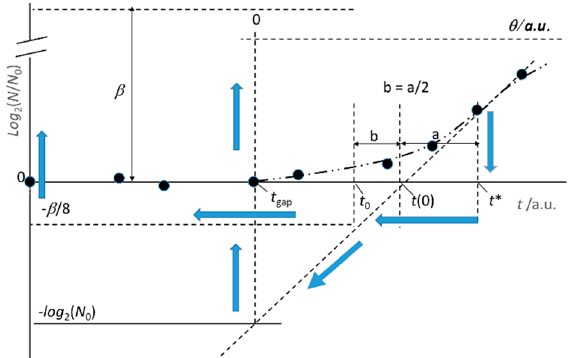
Figure 2. Preliminary steps for a naked eye prediction of the growth parameters. The arrows indicate the estimation steps, according to the guidelines reported in the text. The variable time is “ t ” or “ θ ” for the experimenter and the microbial culture, respectively. Dotted lines correspond to a naked eye estimation. The values of t gap , t 0 , t (0), t *, and β are tentative approximations. N 0 has a known value. Full dots stand for experimental data.